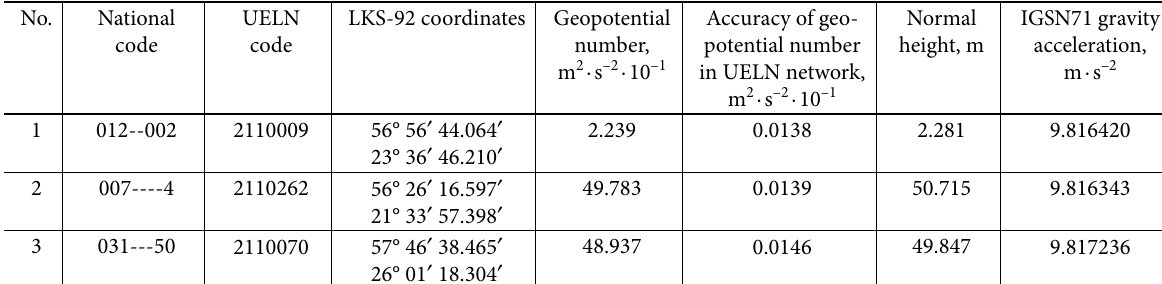
Table 2. Datum points of the Latvian NFOLN